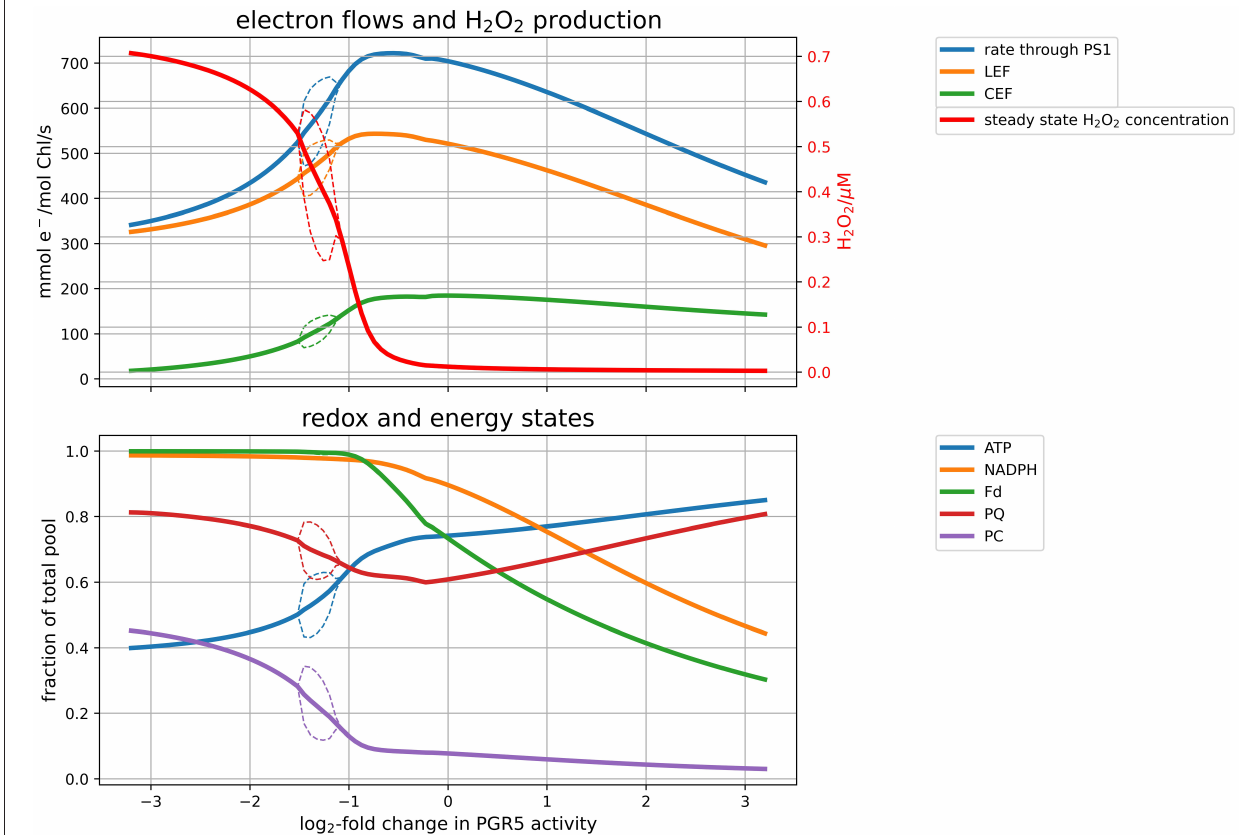
FIGURE 4 | Response of the model under high light (PPFD 1,000 µ molm − 2 s − 1 ) to changes in CEF activity. Altered CEF activity was simulated by changing the rate constant for PGR5, the enzyme transferring electrons from Fd to PQ. The top panel displays electron flows through the PETC and the H 2 O 2 concentrations resulting from the flux through the Mehler reaction and the ASC-GSH cycle. The bottom panel shows the energy (ATP) and redox state (NADPH, Fd, PQ, PC) of the system. In both panels, the solid lines indicate stationary values. The thin dashed lines indicate a parameter range, in which limit cycle oscillations were observed, denoting the minimum and maximum values of the oscillating variable. Outside these parameter regions, the solid line indicates stationary values, within the bubble averages over